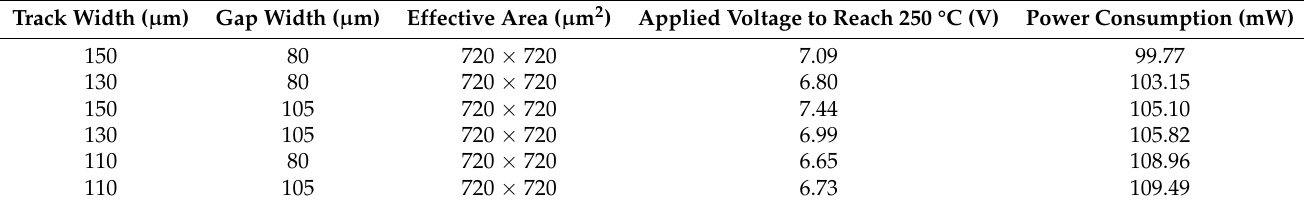
Table 1. Summary of Lowest Power Consumption Values Achieved with Simulations.